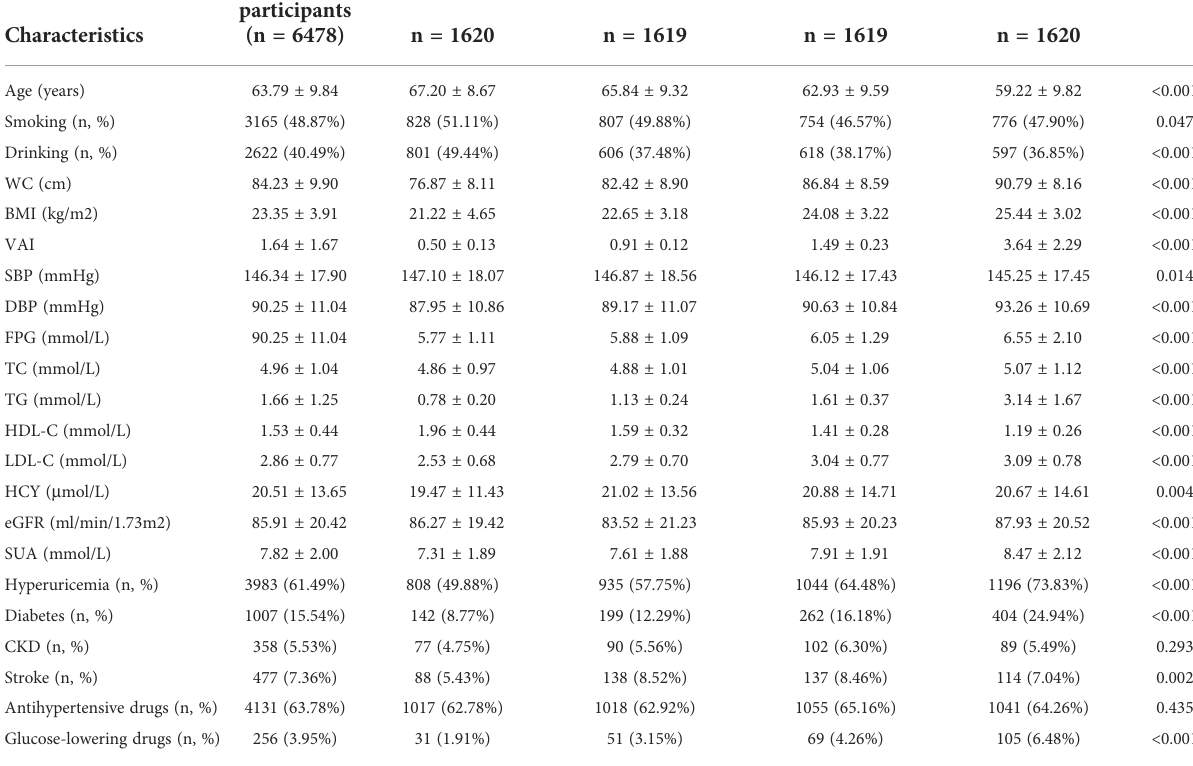
TABLE 1 Baseline characteristics of study participants across visceral adiposity index (VAI) quartiles in